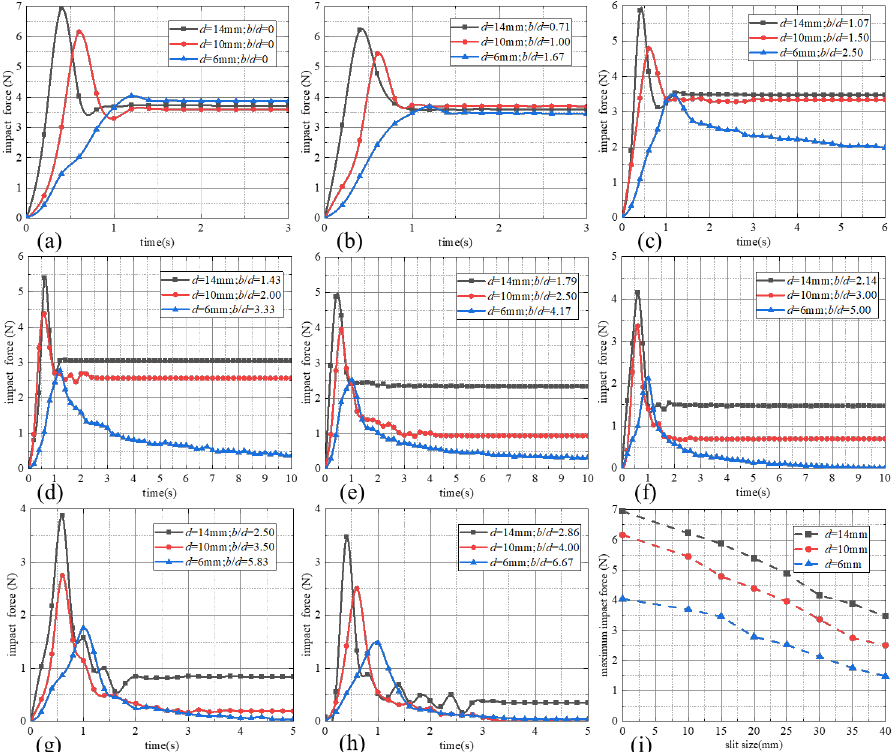
Figure 6. Variation of particle impact force with time in the flume experiment when θ = 45 ◦ . ( a ) b = 0 mm; ( b ) b = 10 mm; ( c ) b = 15 mm; ( d ) b = 20 mm; ( e ) b = 25 mm; ( f ) b = 30 mm; ( g ) b = 35 mm; ( h ) b = 40 mm; ( i ) summary of maximum impact forces for different slit widths. All impact force time history curves were recorded from the moment the particles first contacted the baffle structure.